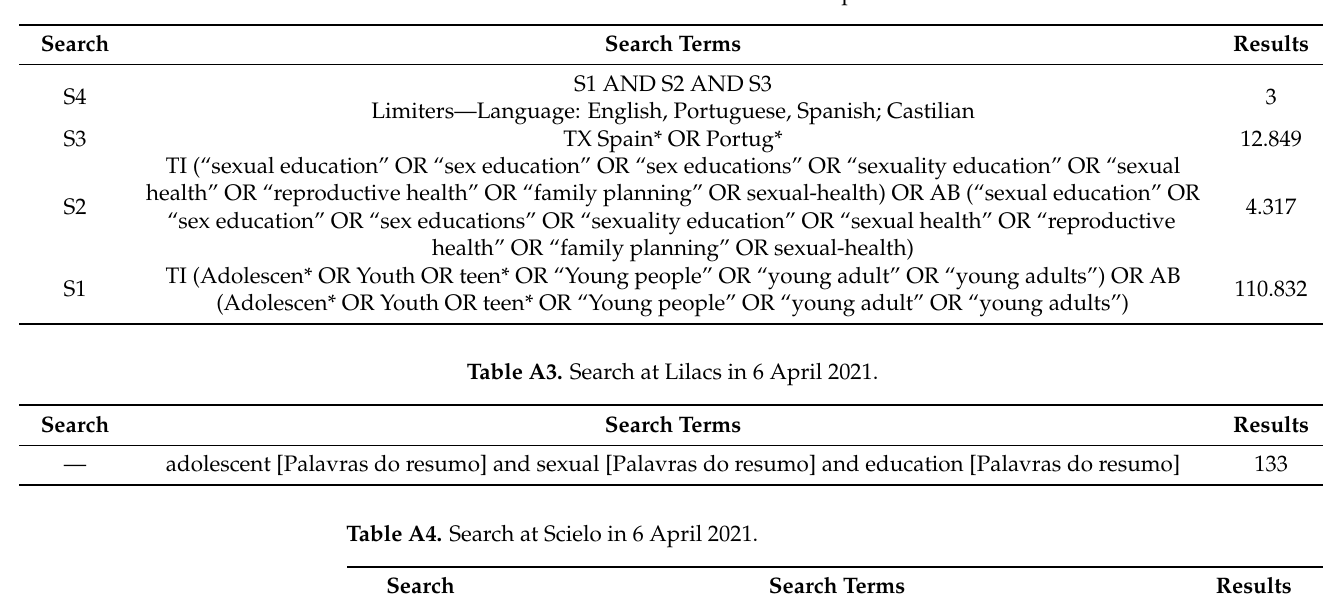
Table A2. Search at ERIC via EBSCO in 6 April 2021.